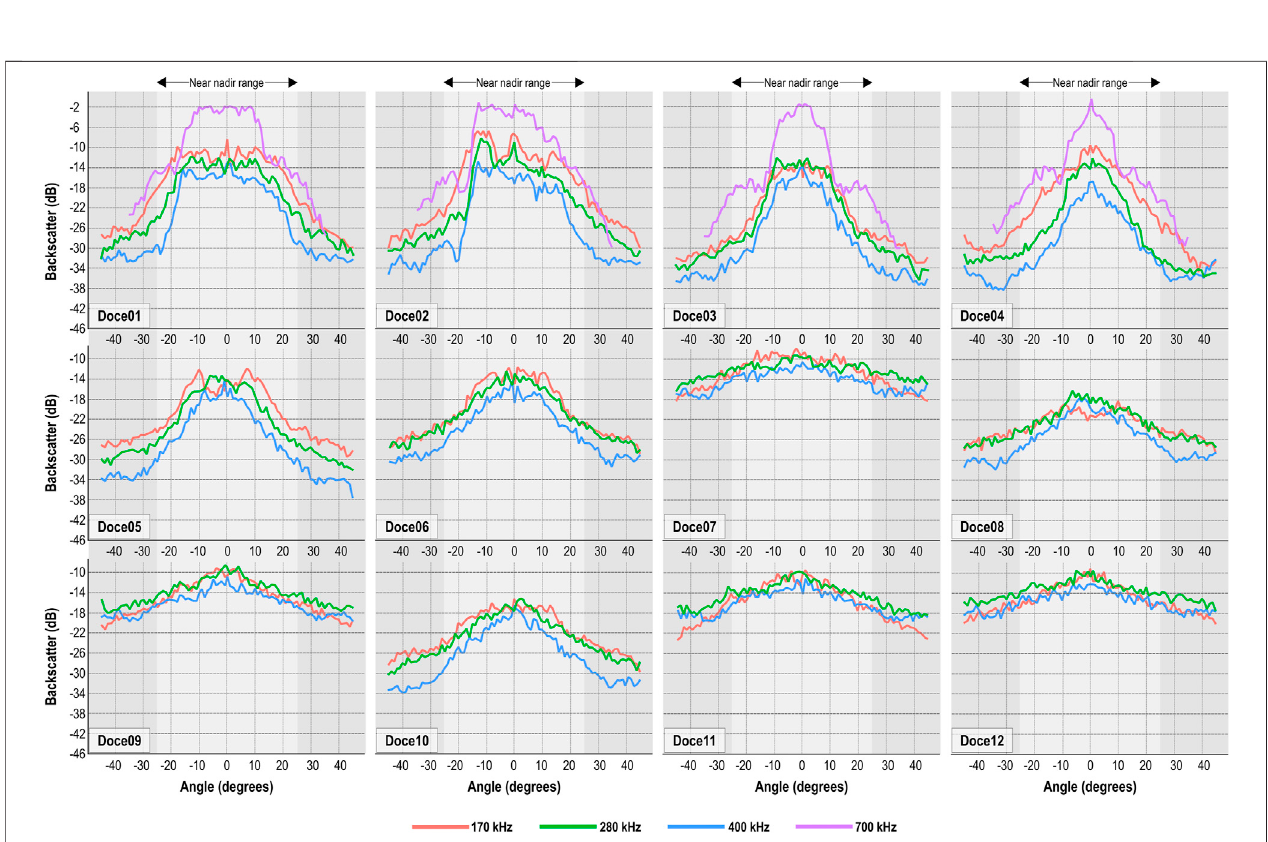
FIGURE 12 | Angular dependence curves for each frequency extracted in each sample site.